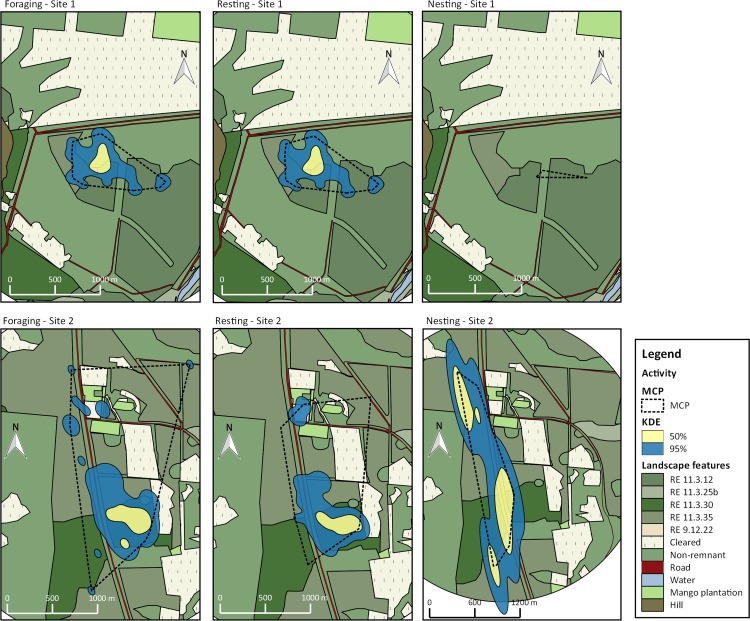
Utilization areas for the flock of BTF Poephila cincta cincta calculated with 95% kde (blue fill), 50% kde (yellow fill) and MCP (dashed line) at Sites 1 (top) and 2 (bottom) for different activities (resting, foraging or roosting) Utilization areas in this analysis are for multiple individuals (flock) tracked at the same site.